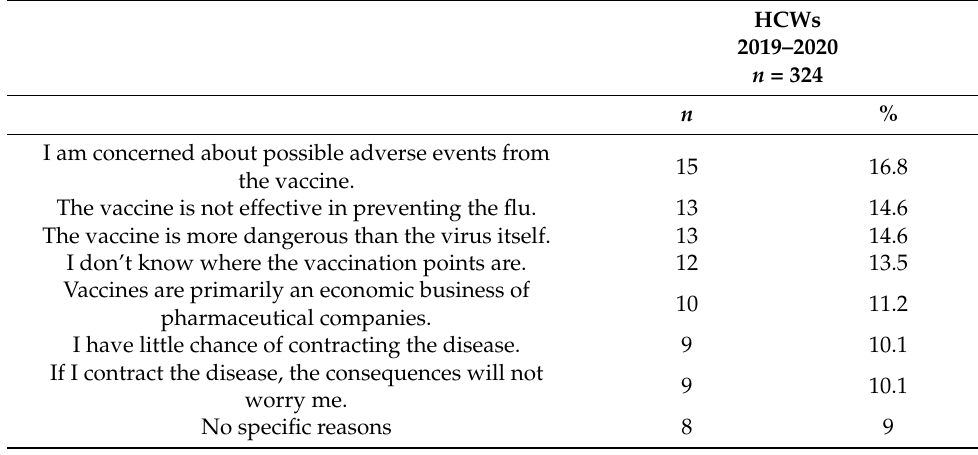
Table 2. Reasons to refuse flu vaccination.